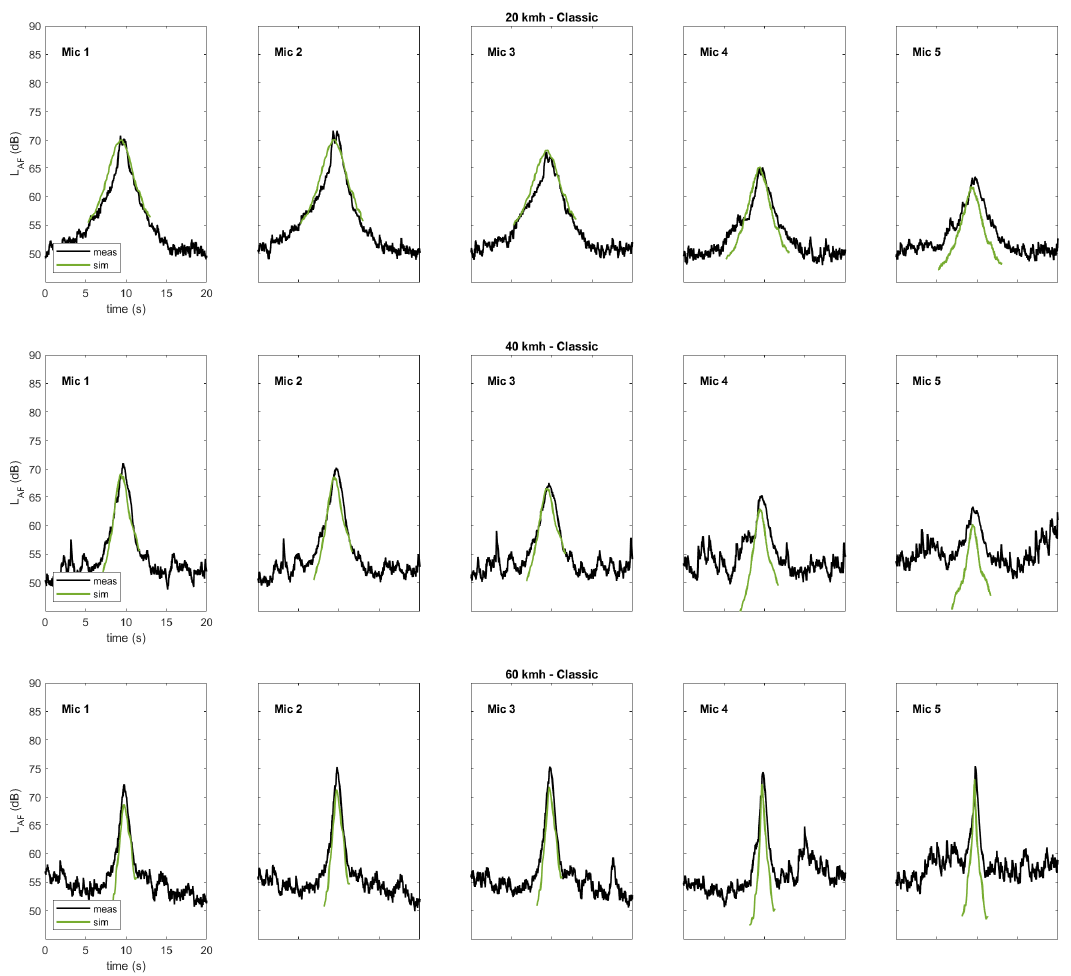
Figure A1. Comparison of measured vs. simulated A-weighted sound pressure level time histories for exemplary flights of the Classic multicopter at three different velocities, shown for all micro- phones.